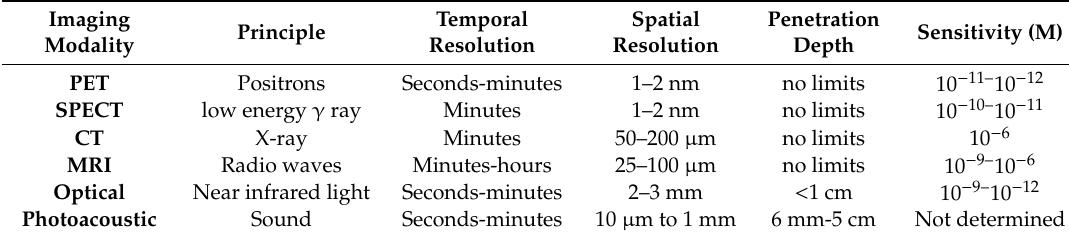
Table 1. Salient features of clinical imaging